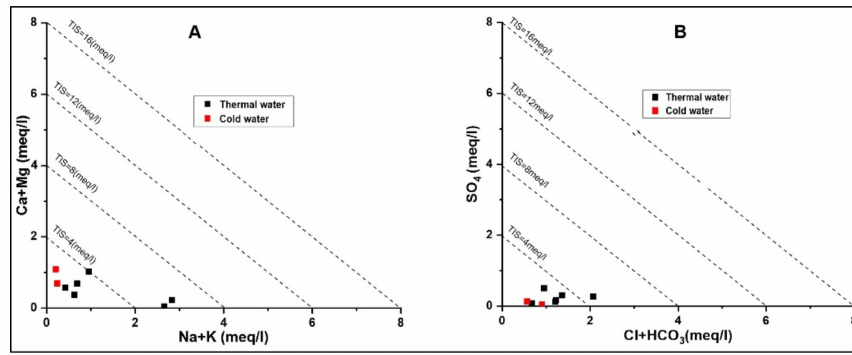
Figure 6. TIS salinity diagrams ( A ) Ca + Mg vs. Na + K, ( B ) SO 4 vs. Cl + HCO 3